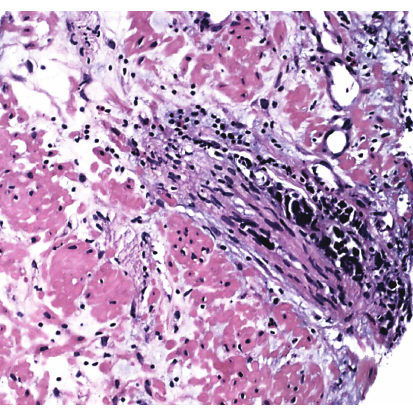
Figure 4: Perineural invasion by the small cell carcinoma compo- nent, diagnosed in a needle biopsy.